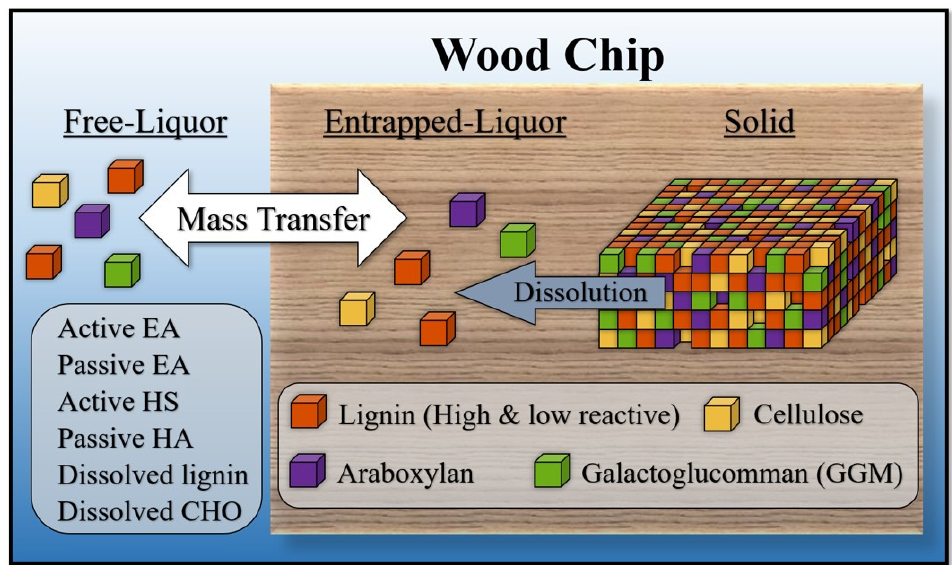
Figure 2. Schematic illustration of a pulp digester composed of three phases (solid, entrapped-liquor, and free-liquor) . Reproduced with permission of the American Automatic Control Council for the conference article